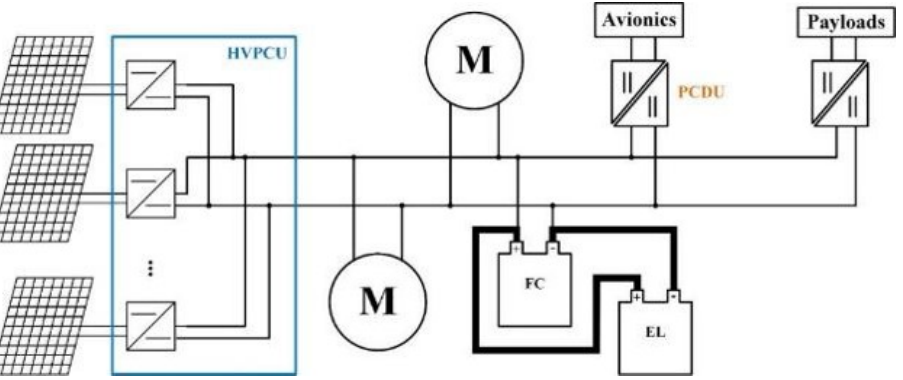
Figure 4. Stratobus electrical architecture illustration made from technical description in [10].